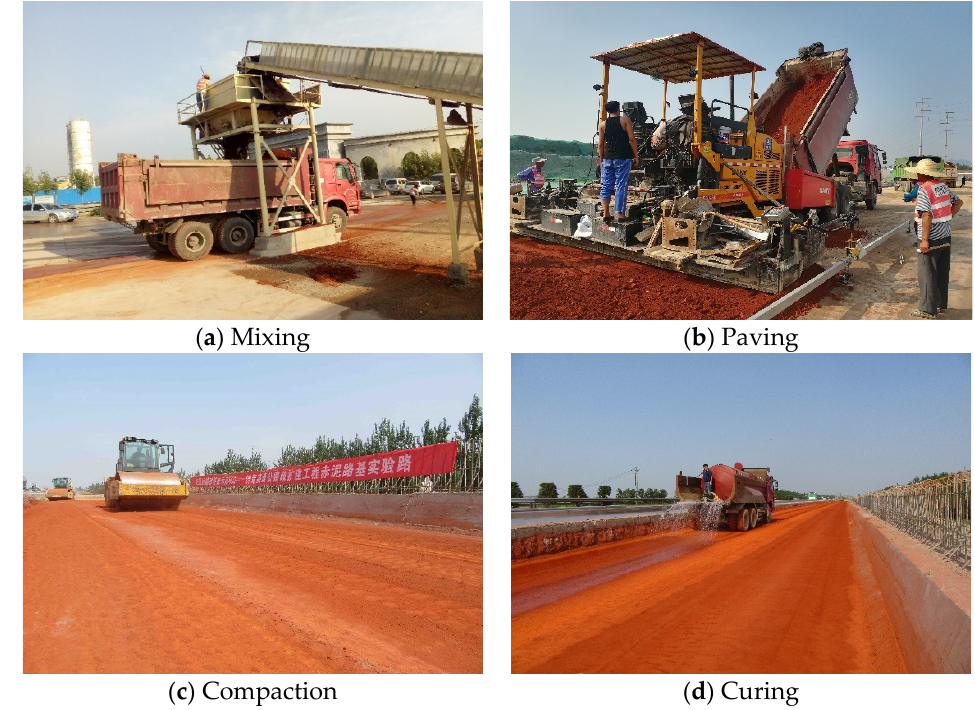
Figure 6. Plant mixing construction of Bayer red mud in a project.